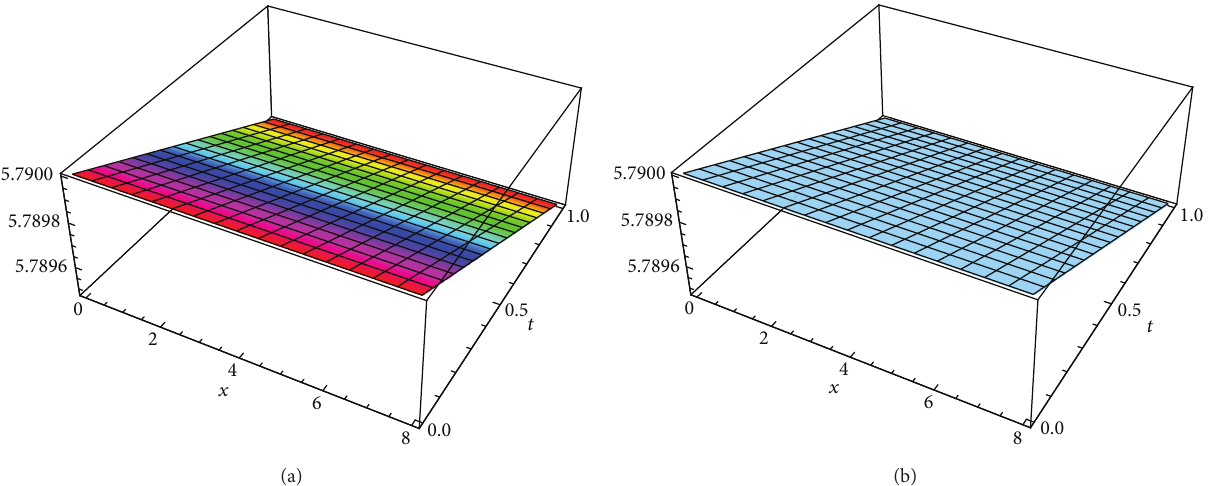
Figure 8: Three-dimensional plot for the solution of Saint Venant equations via homotopy analysis method obtained (a) 𝑦(𝑥,𝑡) = 𝑦 0 + 𝑦 1 + 𝑦 𝑦 𝑦(𝑥,𝑡) = 𝑦 𝑦 2 + 3 + 4 (b)